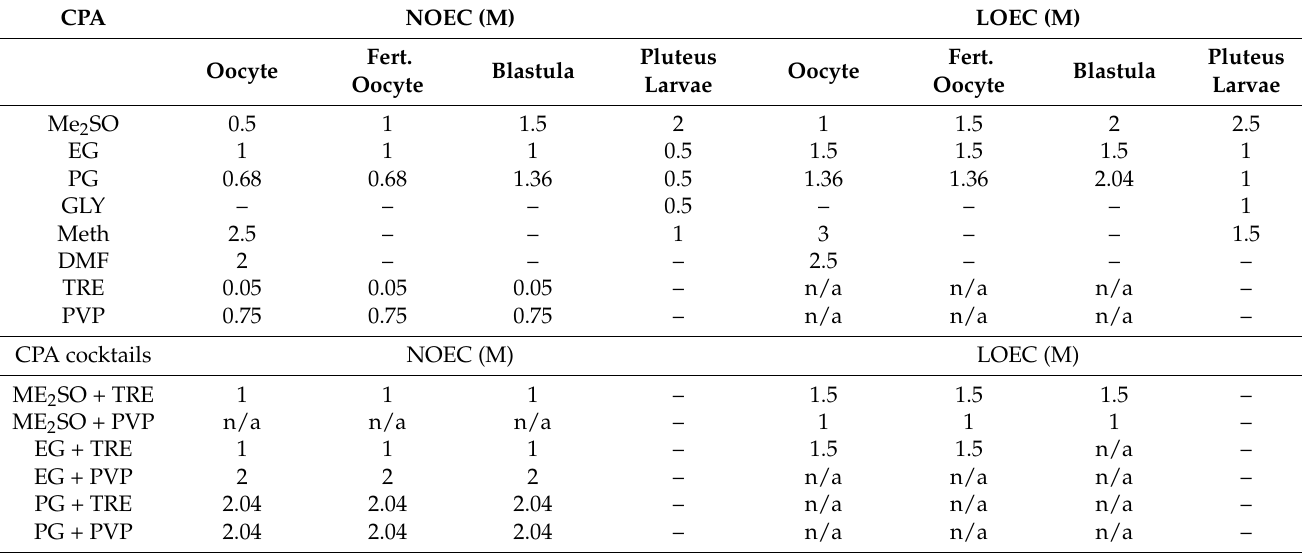
Table 1. Cryoprotecting agents (CPA) toxicity as “No Observed Effective Concentration” (NOEC) and “Lowest Observed Effect Concentration” (LOEC) for 4 cell types of Paracentrotus lividus, following the methodology by [26].